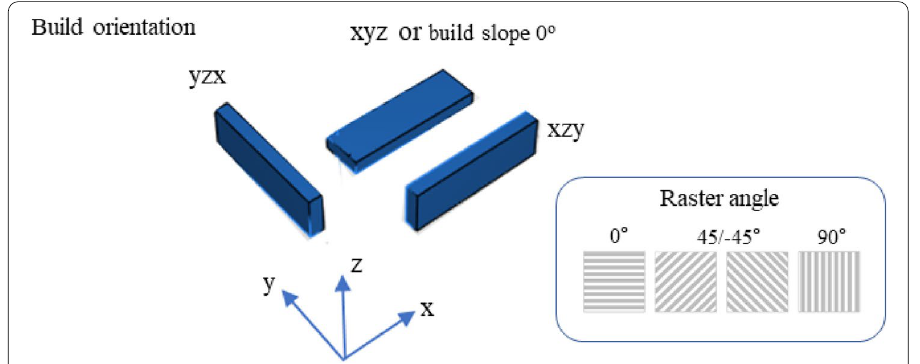
Fig. 3 Raster angle and part orientation, which means build orientation and slope. *Build orientation xyz, xzy, and yzx followed by ISO/ASTM